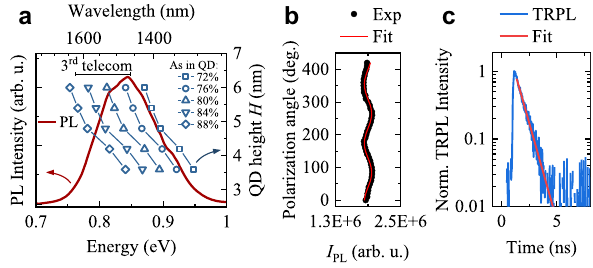
Figure 4: Optical properties of the QD ensemble emission. (a) PL spectrum (left axis) with the calculated X emission energy as a function of QD height and As content (right axis). (b) Integrated PL intensity of QD ensemble as a function of the polarization angle. (c) Time-resolved photoluminescence for the peak of the QD